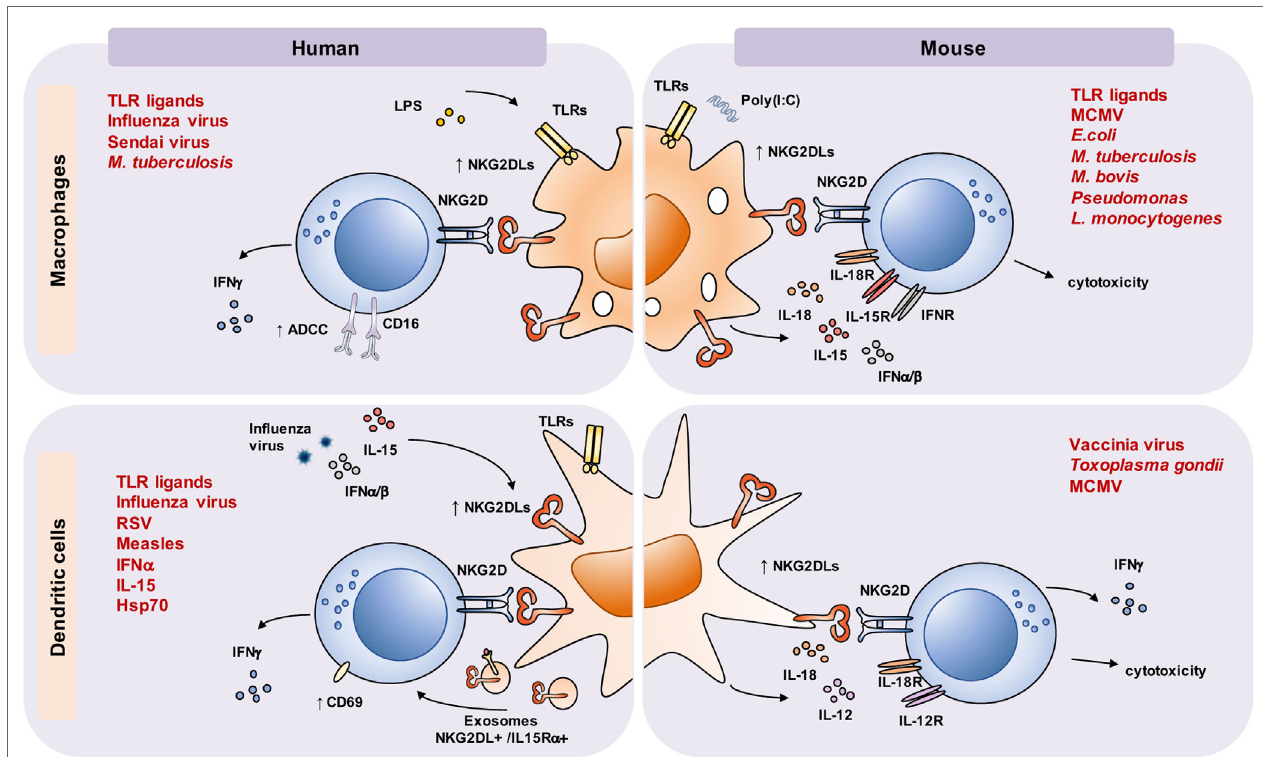
FiGURe 1 | Macrophages and dendritic cells (DCs) activated by toll-like receptor (TLR) ligands, cytokines, viral or bacterial infection upregulate NKG2D ligands (NKG2DLs) and regulate natural killer (NK) cell effector responses. In both mouse and human, TLR activation and viral and bacterial infection were shown to upregulate NKG2DLs on macrophages and DCs. In addition, cytokines produced by myeloid cells upon infection, such as IL-15 or type I IFNs, can also induce NKG2DL expression on DCs and, importantly, increase natural killer group 2, member D (NKG2D) expression on interacting lymphocytes. Induced NKG2DLs interact with NKG2D expressed by NK cells and lead to their activation, resulting in secretion of IFN- γ , cytotoxicity, CD69 upregulation, and increased killing of antibody-coated cells by antibody-dependent cellular cytotoxicity (ADCC). NKG2DLs and IL-15R α /IL-15 can also be delivered to NKG2D + effector cells via exosomes. NK cell responses are further supported by soluble factors released by myeloid cells, including IL-12 and IL-18, which strongly synergize in IFN- γ induction. In turn, IFN- γ released by NK cells supports myeloid cell activation and release of soluble factors, creating a myeloid-lymphoid feedback activation loop. In some instances, activated NK cells can kill NKG2DL-expressing macrophages and DCs, thereby limiting their numbers, their responses, or improper stimulation. Abbreviations: RSV, respiratory syncytial virus; MCMV, mouse